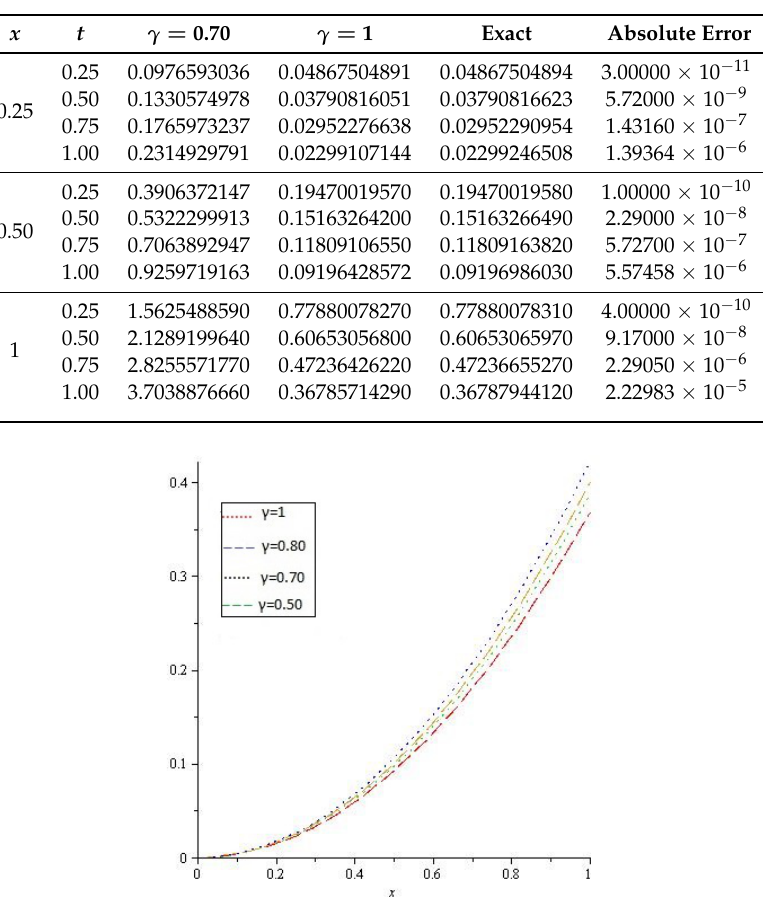
Table 3. Numerical results of Example 3 at γ = 0.70 and γ = 1.